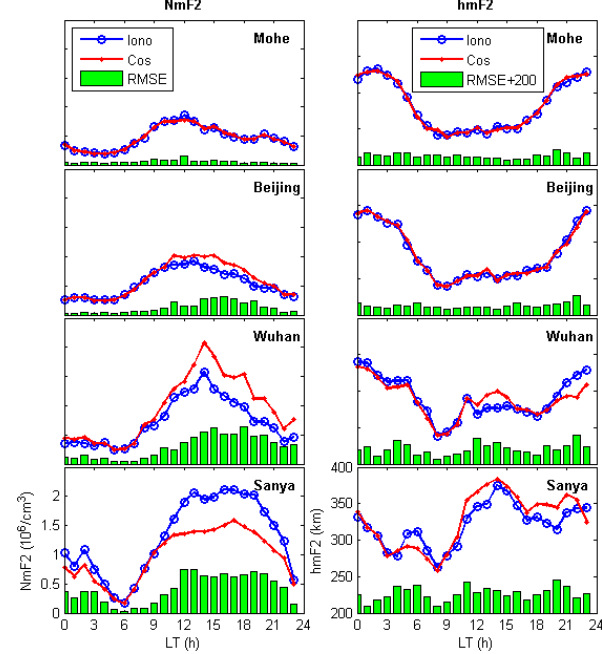
Figure 3. Comparison of diurnal variations of ionospheric parame- ters Nm F2 (left panels) and hm F2 (right panels) from COSMIC and ionosonde measurements for different stations. The blue circle, red dot and green bar stand for parameters from ionosondes (“Iono”) and COSMIC satellite (“Cos”) and the RMSE between them. Note that a bias of 200 is added to the RMSE of hm F2s in the right-hand